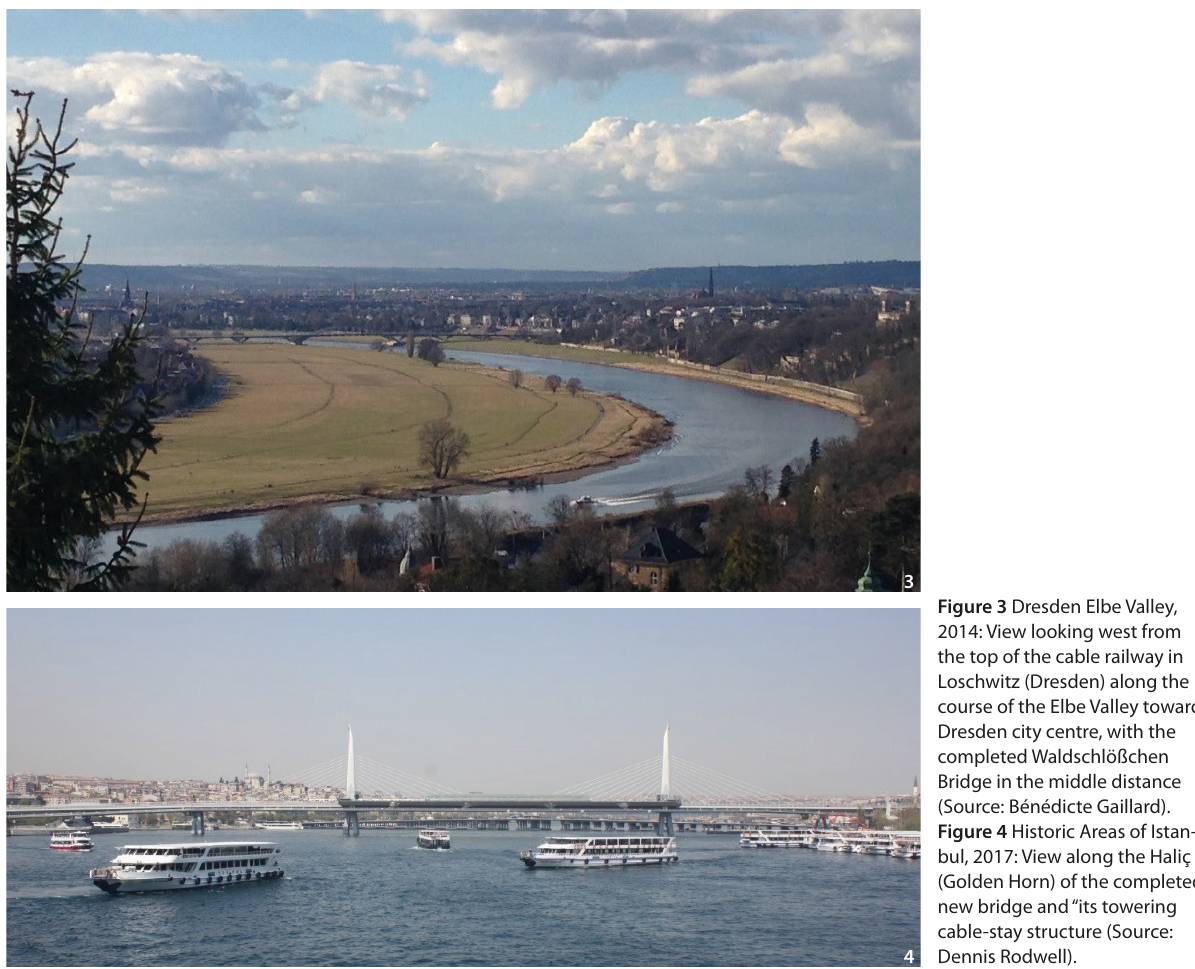
Figure 3 Dresden Elbe Valley, 2014: View looking west from the top of the cable railway in Loschwitz (Dresden) along the course of the Elbe Valley towards Dresden city centre, with the completed Waldschlößchen Bridge in the middle distance (Source: Bénédicte Gaillard). Figure 4 Historic Areas of Istan- bul, 2017: View along the Haliç (Golden Horn) of the completed new bridge and “its towering cable-stay structure (Source: Dennis